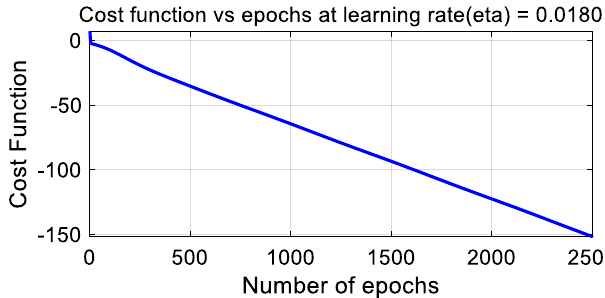
Figure 9. Cost function vs. eta (Epochs at learning rate) for mixing parameters.